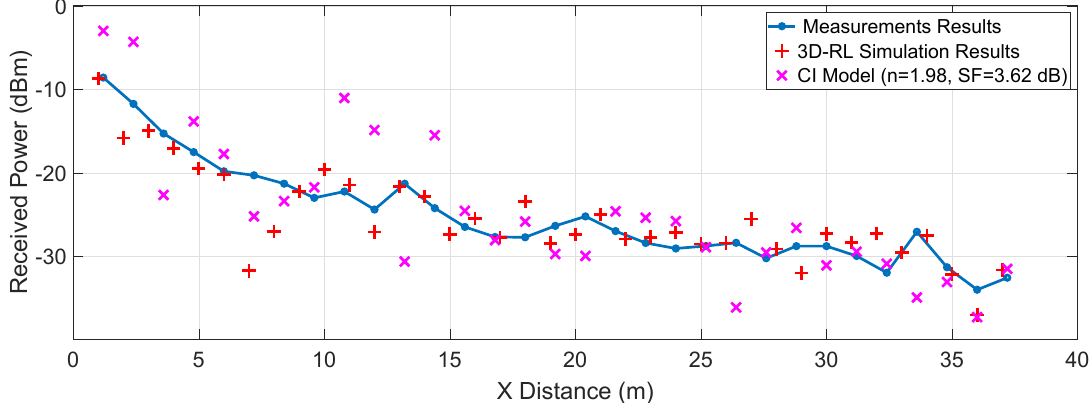
Figure 16. Measurement results for P 1 to P 31 locations (see Figure 8 for reference), 3D-RL simulation results for these spatial positions, and a CI free-space model approximation ( n = 1.98 σ SF = 3.62